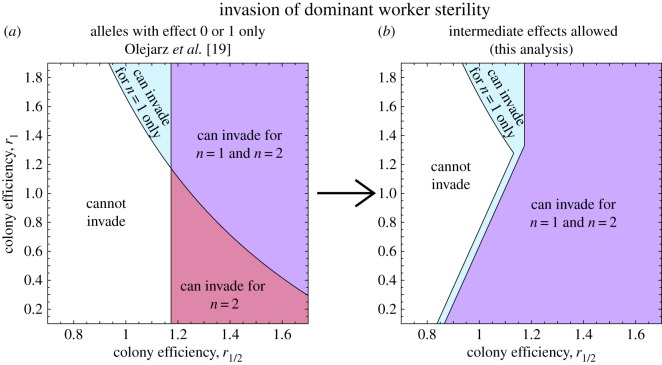
The invasion of worker sterility under dominant genetics, exploring the regions of parameter space where sterility can invade under single mating (n=1) only, double mating (n=2) only, both or neither. (a) If we assume that only full-sterility alleles can arise, as Olejarz et al. [19] did, double mating sometimes promotes the invasion of sterility relative to single mating. But (b) if we assume that alleles encoding intermediate worker sterility can arise, double mating does not promote the invasion of sterility relative to single mating. For comparison with fig. 8 of Olejarz et al. [19], we assume pz=0.2+0.8z, and for rz we use the unique quadratic curve passing through the points specified by r0=1, r1/2 and r1.